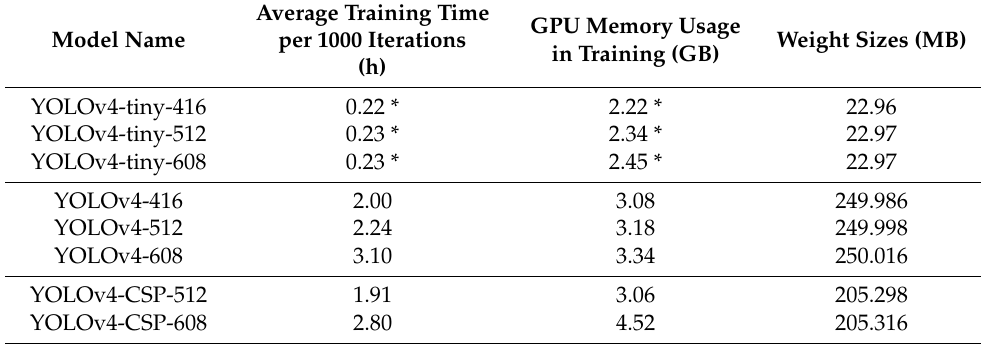
Table 6. Details regarding training YOLOv4